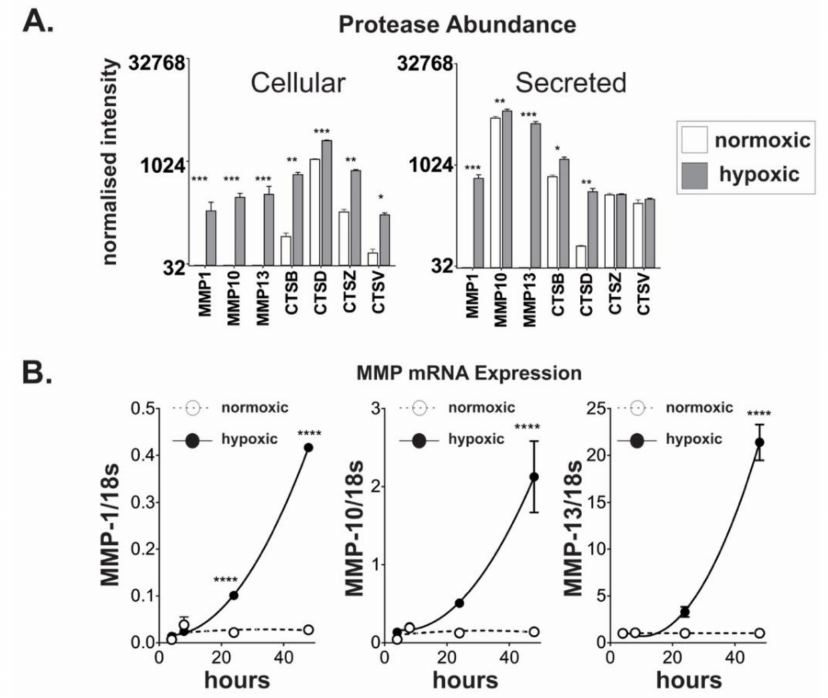
Figure 3. Hypoxia regulates protease expression in ovarian cancer cells. Cell lysates and conditioned media from OVCAR4 cells grown under normoxia and hypoxia were analysed for abundance of 27 di ff erent human proteases (Supplementary Table S1) using antibody arrays. ( A ) Normalized detection intensities for cellular and secreted proteases (MMP1, MMP10, MMP13, CTSB, CTSD, CTSZ, and CTSV) that were significantly di ff erent following hypoxic incubation of OVCAR4 cells. ( B ) Expression levels of MMP1 , MMP10 , and MMP13 were validated by qRT-PCR. The data represent the mean ± SD, n = 3 / group. * p < 0.05; ** p < 0.01; *** p < 0.001; **** p <